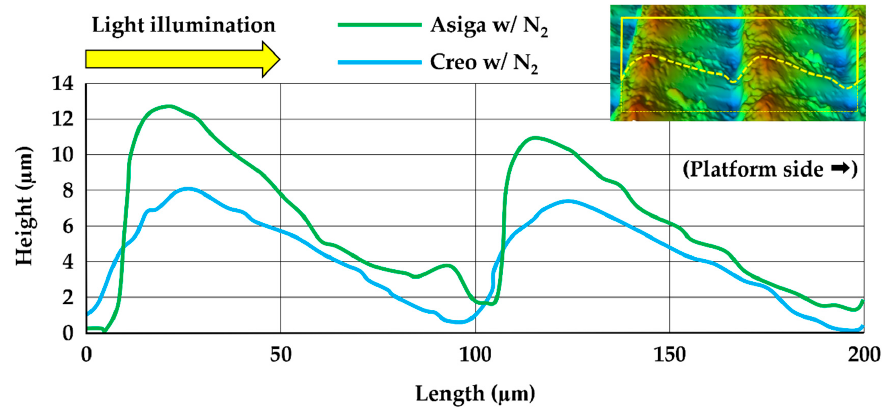
Figure 7. The typical cross-sectional profiles of the specimens post-cured with N 2 obtained by Optical profilometer (OP). A significantly increased surface height variation was noted in Asiga specimen.